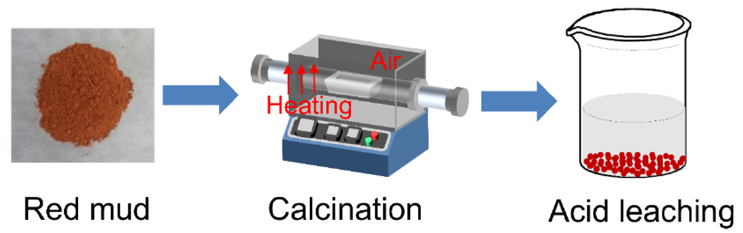
Figure 3. The schematic diagram for the diluted acid leaching strategy of red mud.